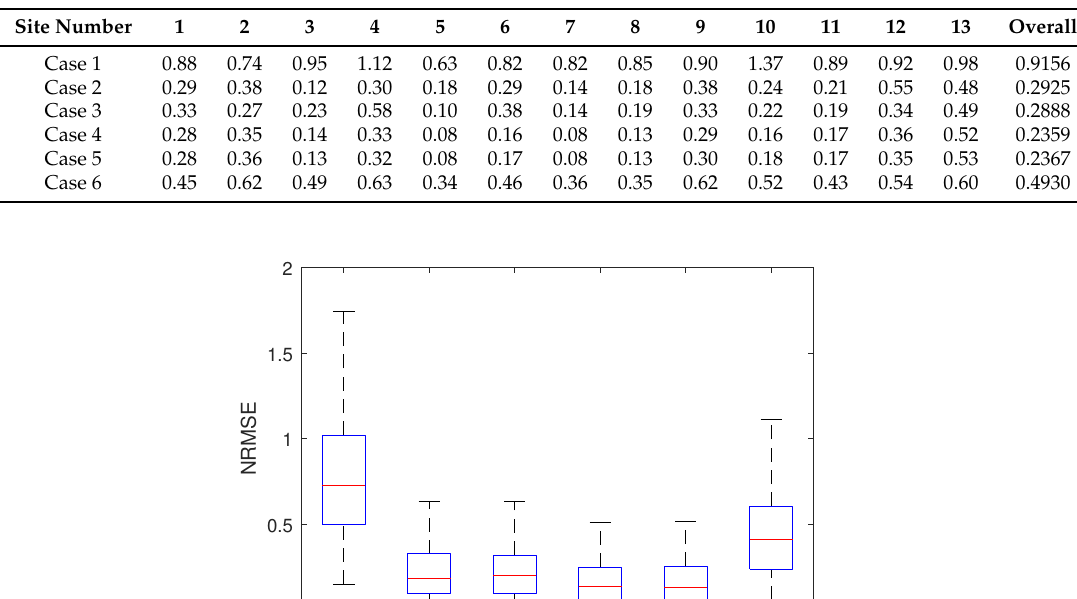
Table 9. Imputation normalized root mean square error (NRMSE).